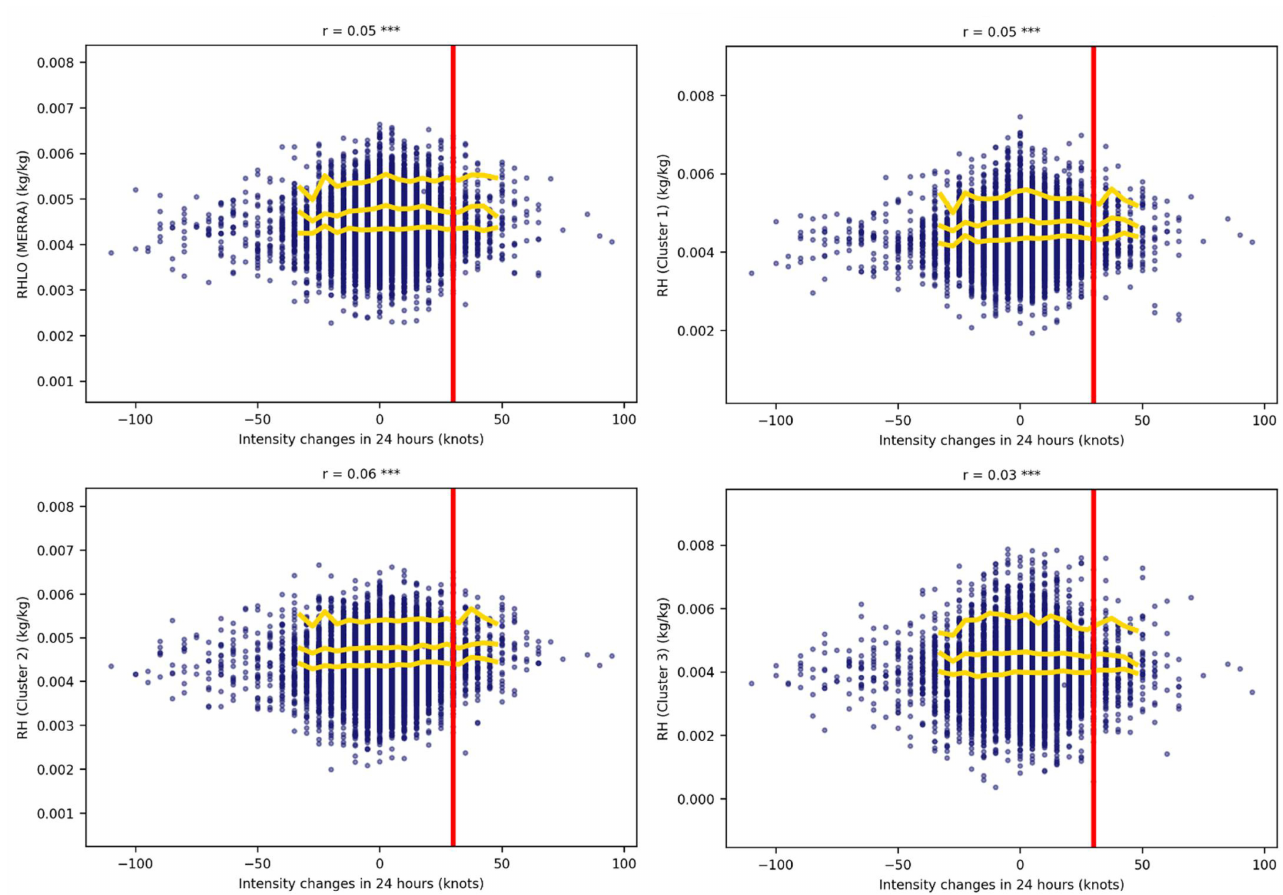
Figure 8. Scatter diagrams of 24-h TC intensity change versus RHLO (MERRA) , RH (Cluster 1) , RH (Cluster 2) and RH (Cluster 3) . The red vertical line in each panel shows the boundary of rapid intensification, and the yellow curves show 95th, 75th, and 50th percentiles in each intensity change bin. Notes: *** p <